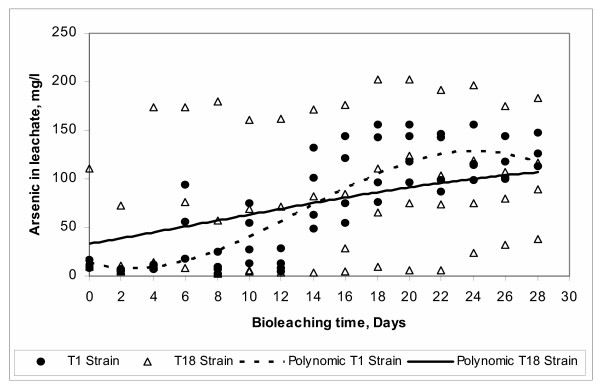
Effect of Strain